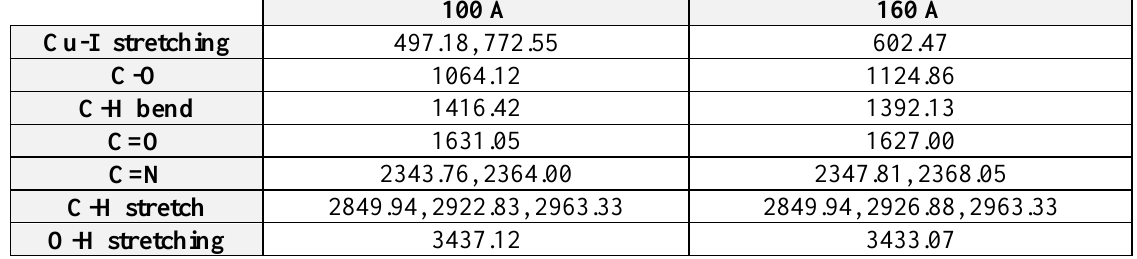
Fig. 3: FTIR for produced CuI nanoparticles using 100 and 160 A current. Table 2: FTIR bonds of CuI nanoparticles produced by two different